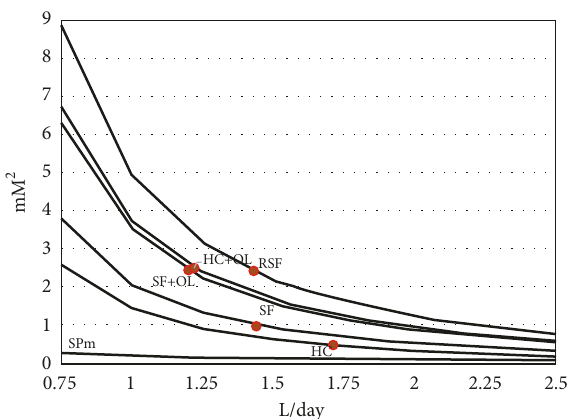
Figure 4: Molar urinary concentration products of Ca times Ox (CP m , mM 2 ) in stone formers (SF) and healthy controls (HC), with dietary Ox load (+OL) and in recurrent SF (RSF) compared to molarsolubilityproductsofCaOx(SP m )atdifferentstatesofdiuresis (L/day): CP m at the average diuresis in the group (o).